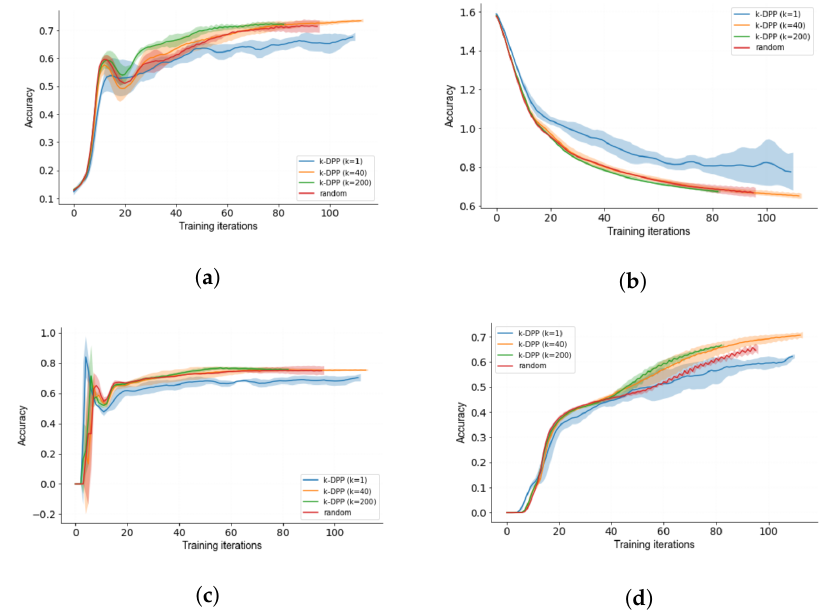
Figure 4. Active learning curves with error bounds for ( a ) accuracy, ( b ) loss, ( c ) recall and ( d ) precision.